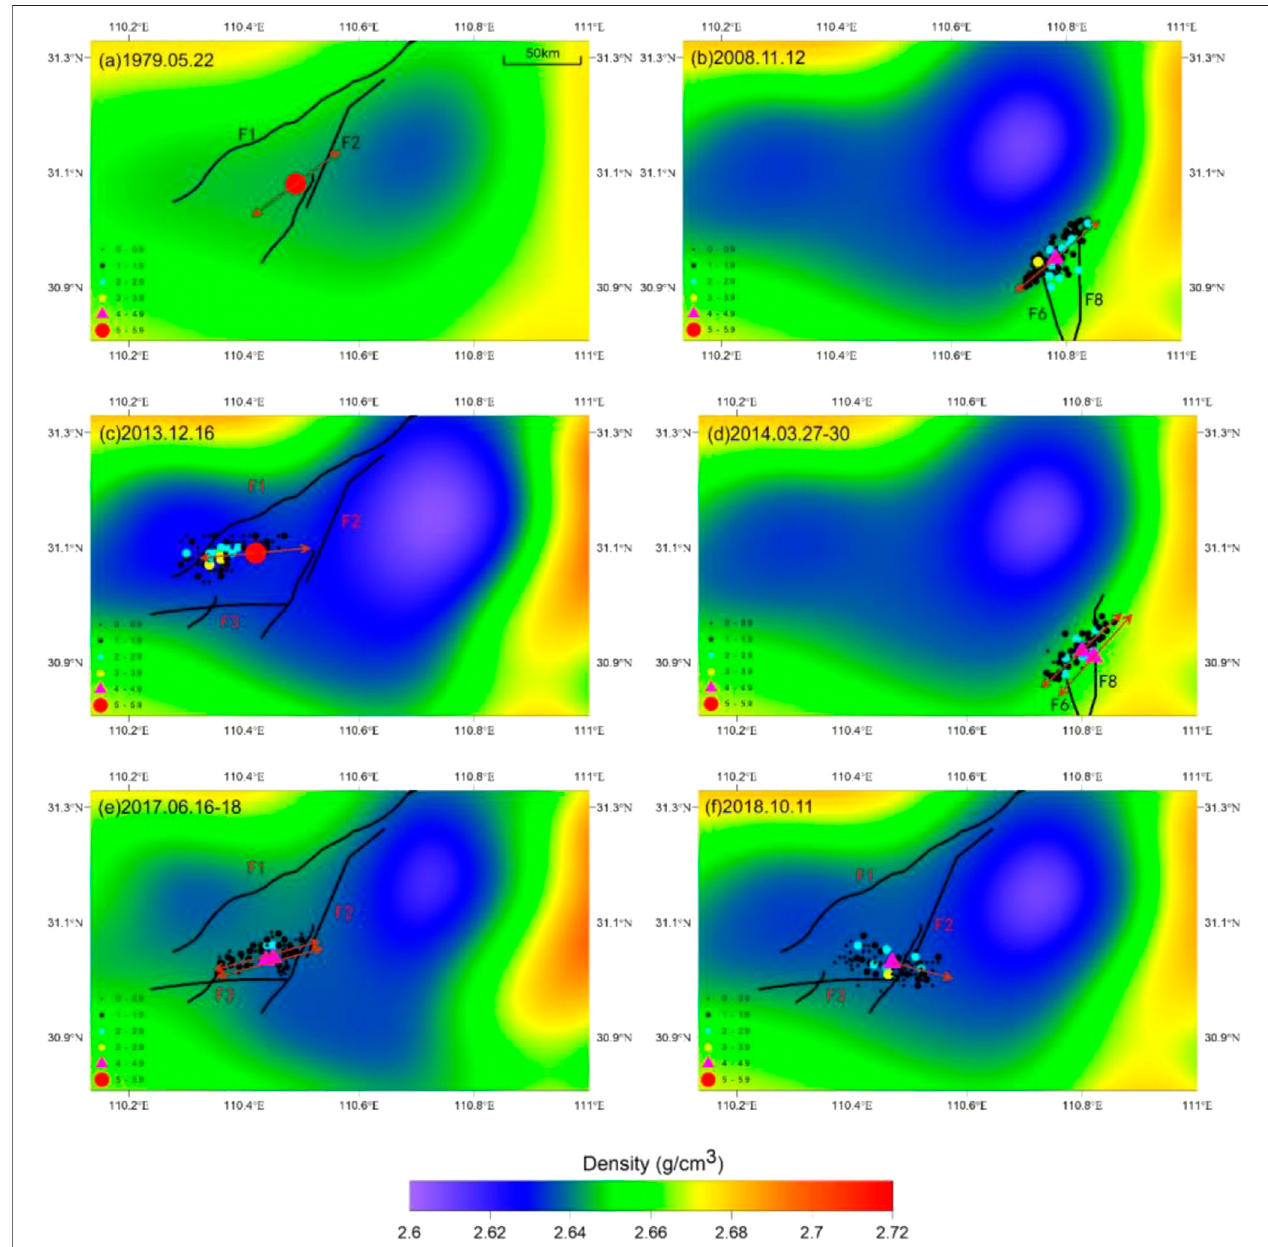
FIGURE 6| Spatial distribution of seismic sequences and trends in regional crustal movements in seismic source areas. (F1 Gaoqiao fault, F2 Niukou-Zhoujiashan fault, F3 Maluchi fault, F6 Xiannvshan fault, and F8 Jiuwanxi fault. The panel A represents the Zigui earthquake in 1979, The panel B represents the Zigui earthquake in 2008, The panel C representsthe Badong earthquake in 2013, The panel D represents the Zigui earthquake in 2014, The panel E representsthe Badong earthquake in 2017, The panel F represents the Zigui earthquake in 2018). The red arrow indicates the trend of regional crustal movement at the seismic focus.